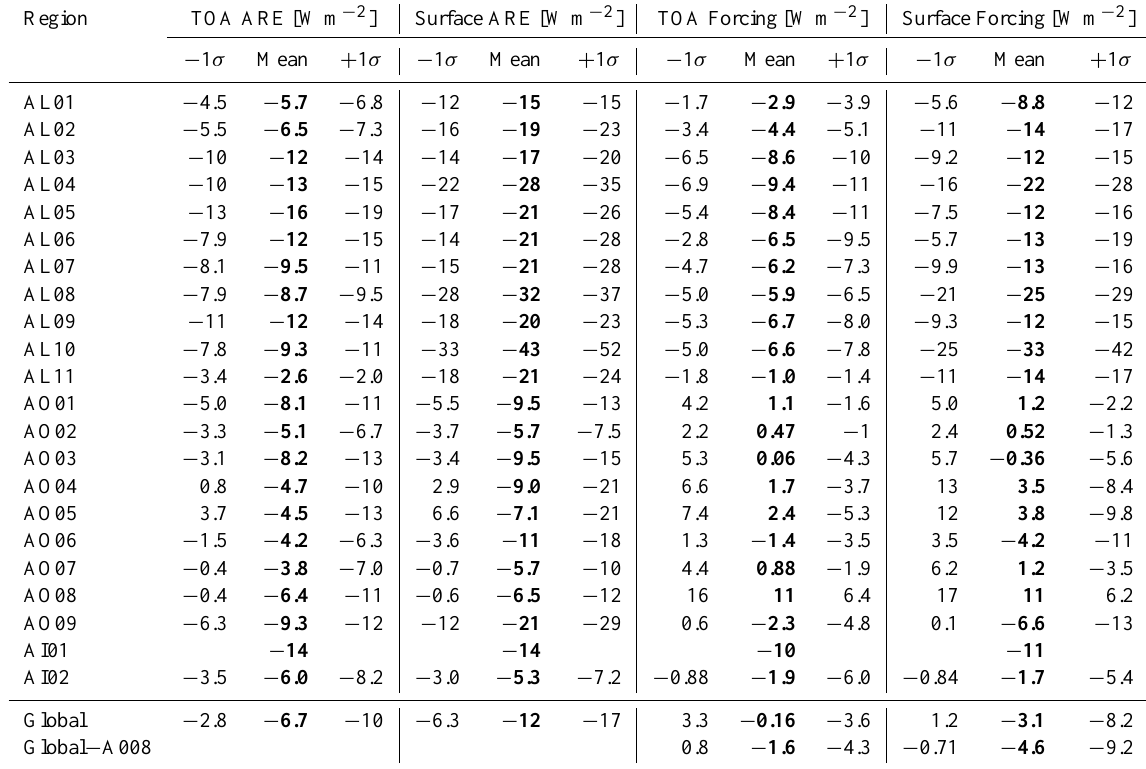
Table 4. Annual regional mean and ± 1 σ values (where σ is the standard error) of the aerosol radiative effect and forcing for 2006 at the surface and